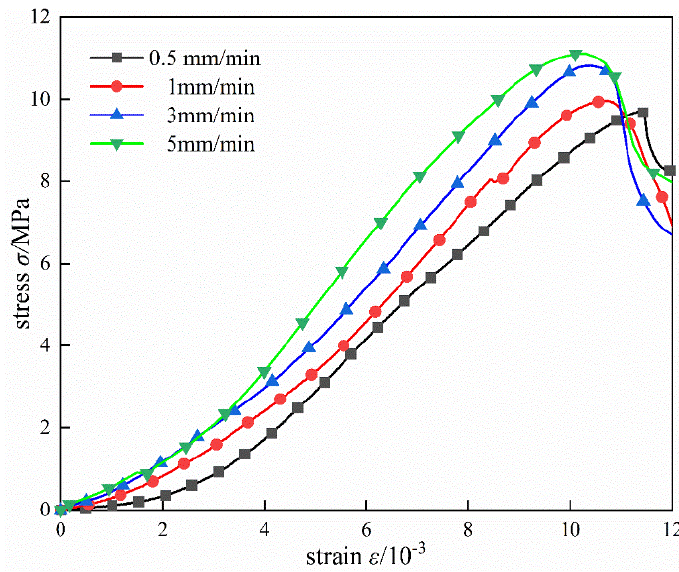
Figure 3. The stress – strain relationship of rock − like under different loading rates.